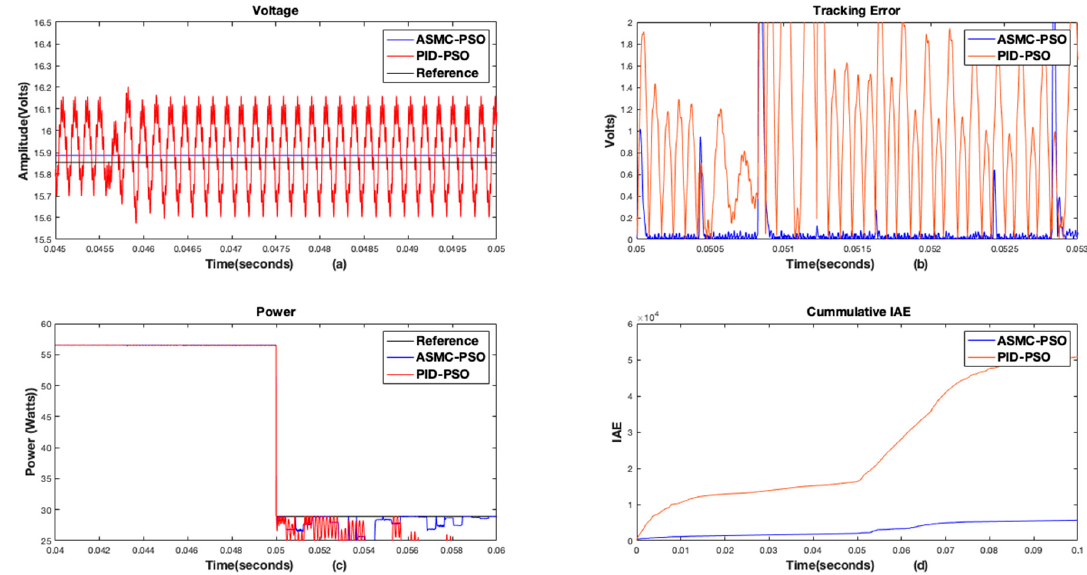
Figure 8. PID & ASMC based in PSO MPPT with 10 particles ( a ) Profile of the PV panel voltage. ( b ) Tracking response ( c ) Profile of the PV power extraction ( d ) IAE.